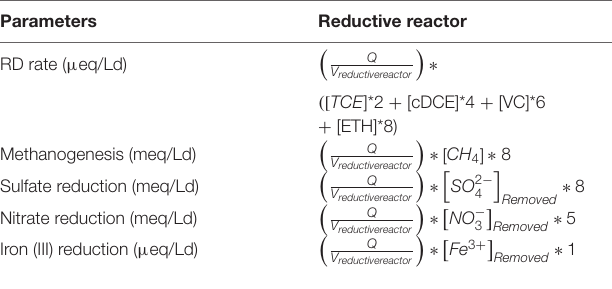
TABLE 2 | Calculations for the estimation of efficiency in VC and cis -DCE removal occurring in the oxidative reactor.